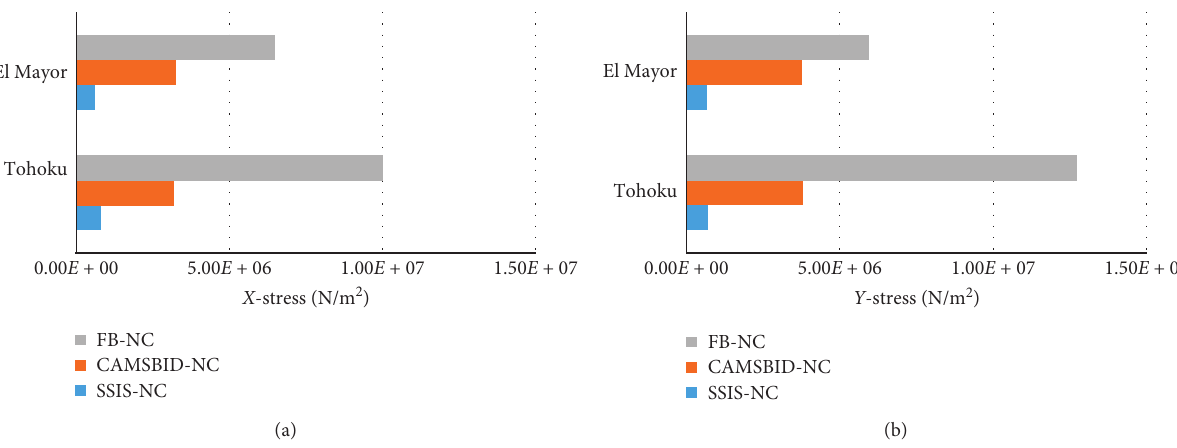
Figure 19: Comparison of peak X -stress (a) and Y -stress (b) responses of the SSIS-NC, CAMSBID-NC, and FB-NC